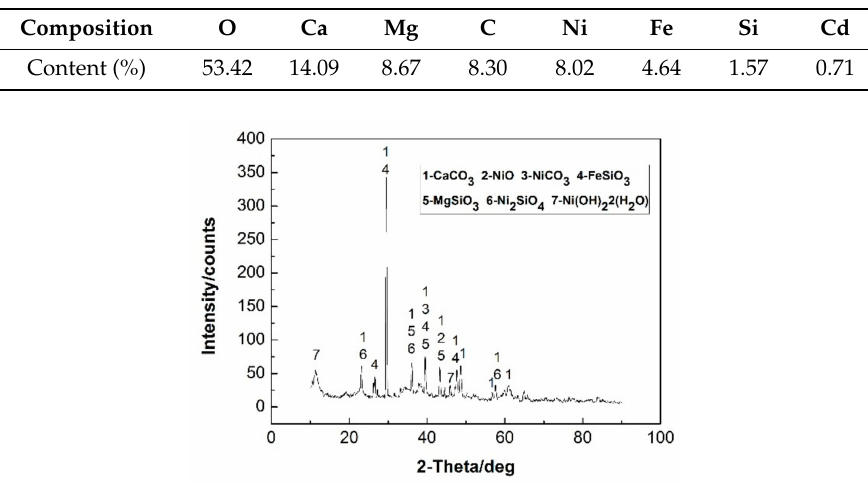
Table 1. Chemical composition of the nickel-containing sludge (NCS) residue.